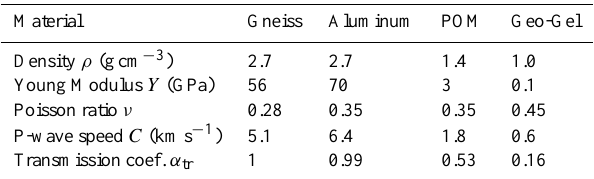
Table 1. Relevant properties of materials used in the construction of the AE casing, after Weber et al. (2012). P-wave speed is esti- q Y 1 − ν mated as C = . The transmission coefficient rela- ρ ( 1 + 2 ν)( 1 + ν) tive to gneiss is calculated as α tr =1 − ((Z x − Z g )/(Z x + Z g )) 2 , where Z x = ρ x C x is the acoustic impedance of material x and Z g that of gneiss.